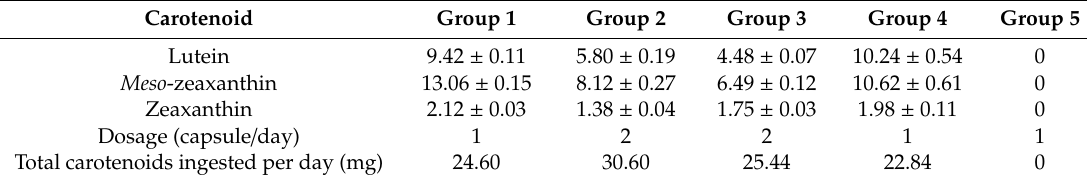
Table 2. Carotenoid concentrations analysed per capsule interventions 1 .